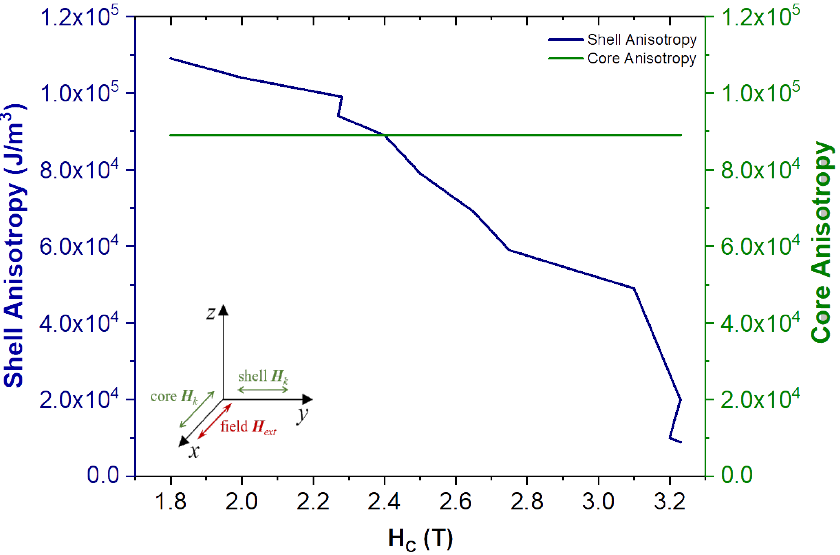
Figure 10. Effect of different anisotropy magnitudes and directions on the NPs core and shell. Anisotropy easy axis directions were defined as; (1,0,0) x-axis for the core; and (0,1,0) y-axis for the shell. As one can see, as the anisotropy in the shell is increased the coercivity of the entire NP decreases, pointing to the importance of the anisotropy direction and magnitude, in core-shell structures, to the overall magnetization dynamics of the